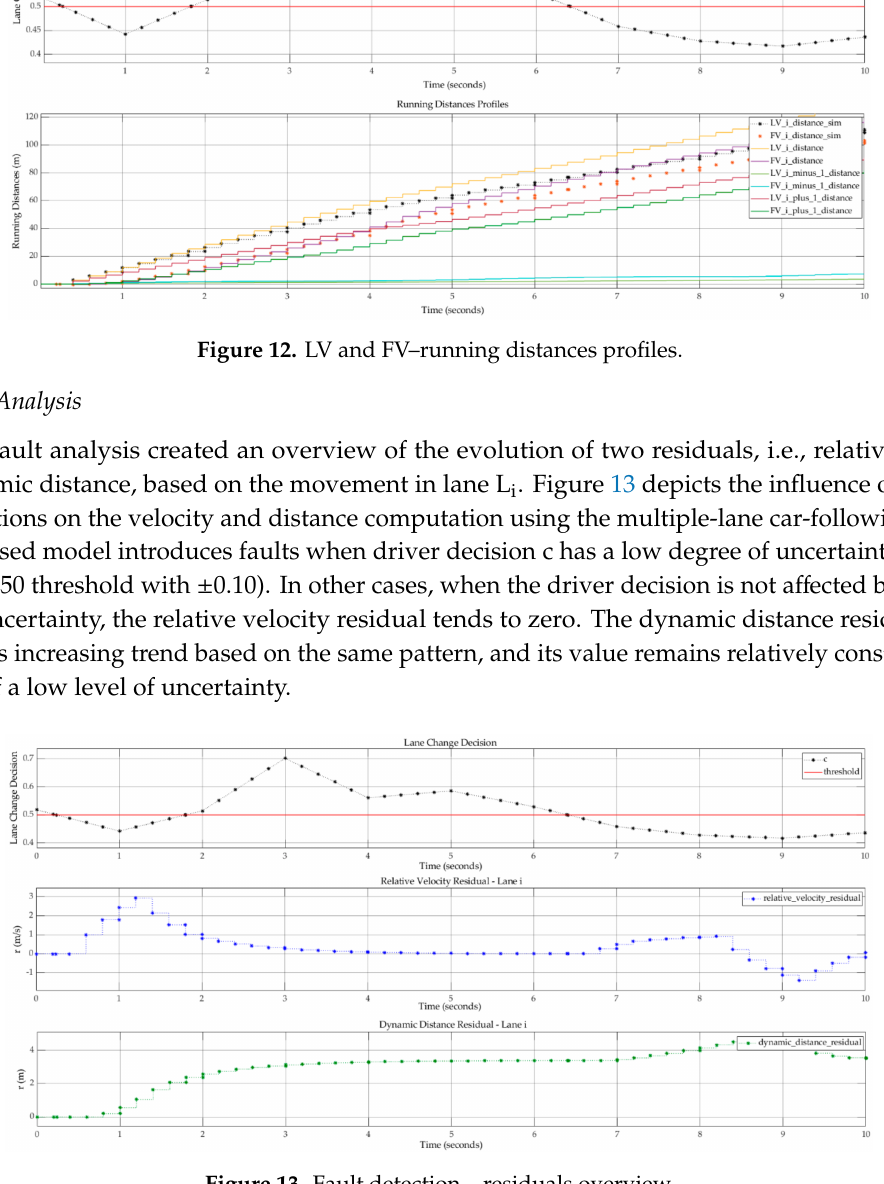
Figure 13. Fault detection – residuals